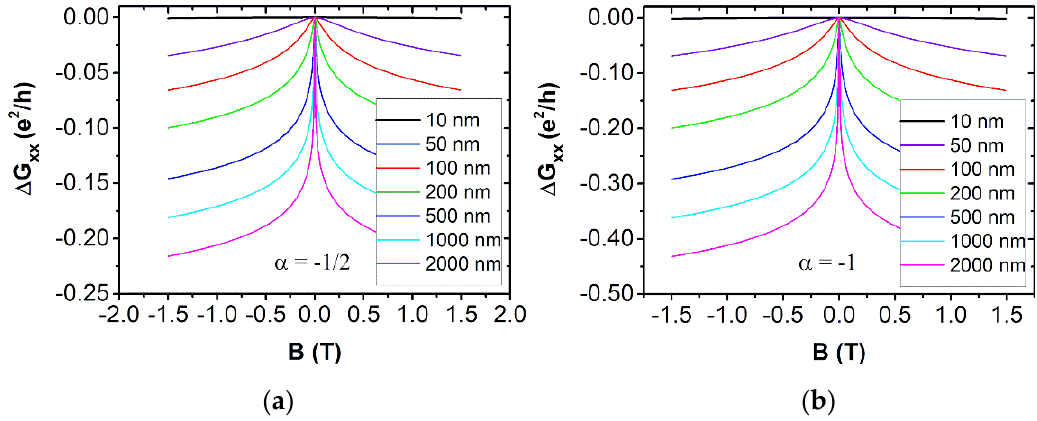
Figure 5. Simulations within the HLN model of the magnetoconductance ∆ G xx ( B ) for different values of l ϕ at fixed α : ( a ) a single coherent channel α = − 1/2. ( b ) Two independent channels α = −